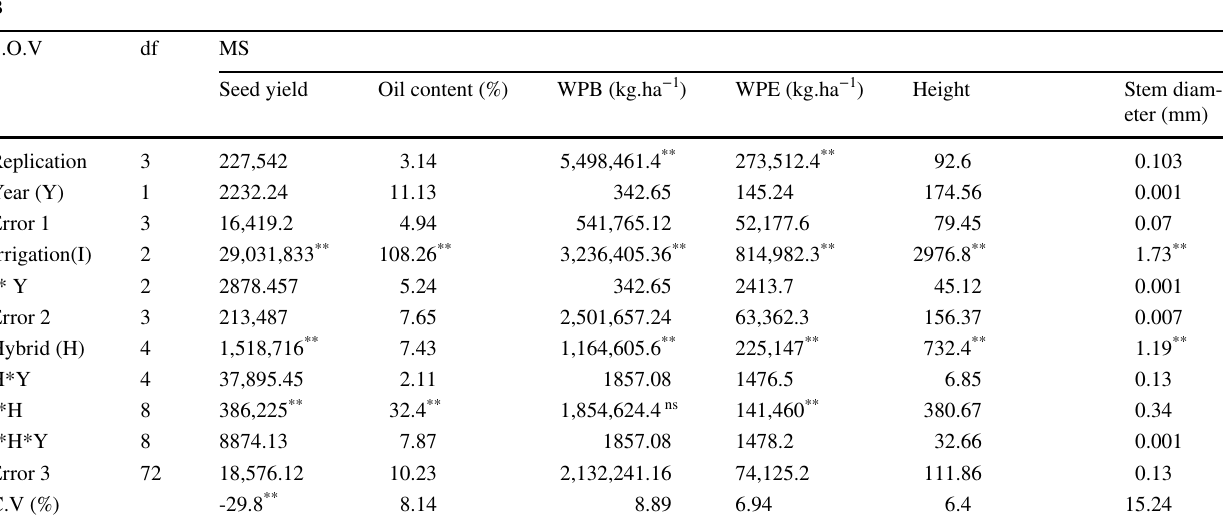
* , **are significantly different at α = 0.05 and α = 0.01, respectively, and ns